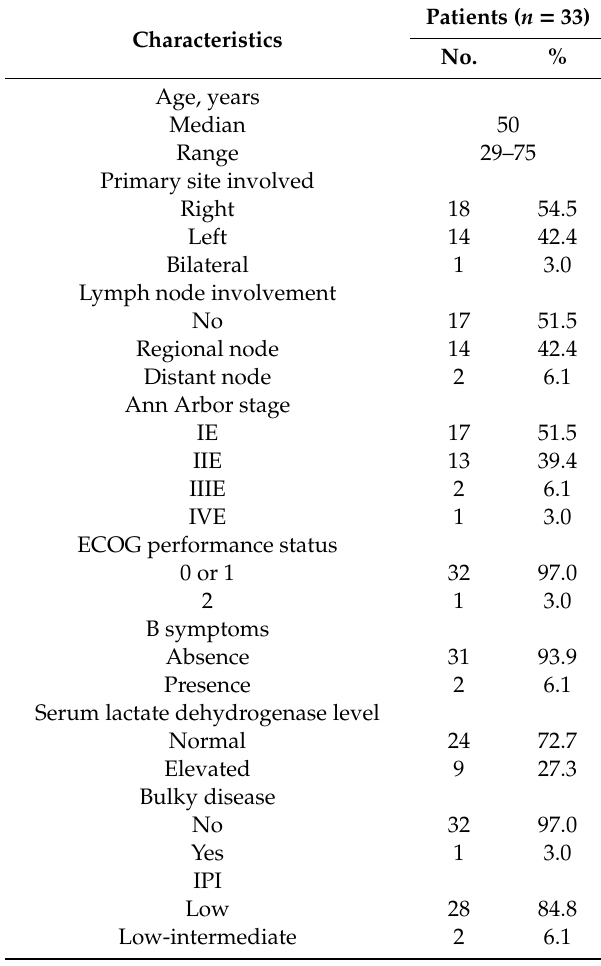
Figure 1. Trial profile. Abbreviations: IT-MTX, intrathecal methotrexate; R-CHOP, rituximab plus cyclophosphamide, doxorubicin, vincristine, and prednisone. Table 1. Baseline clinical characteristics.